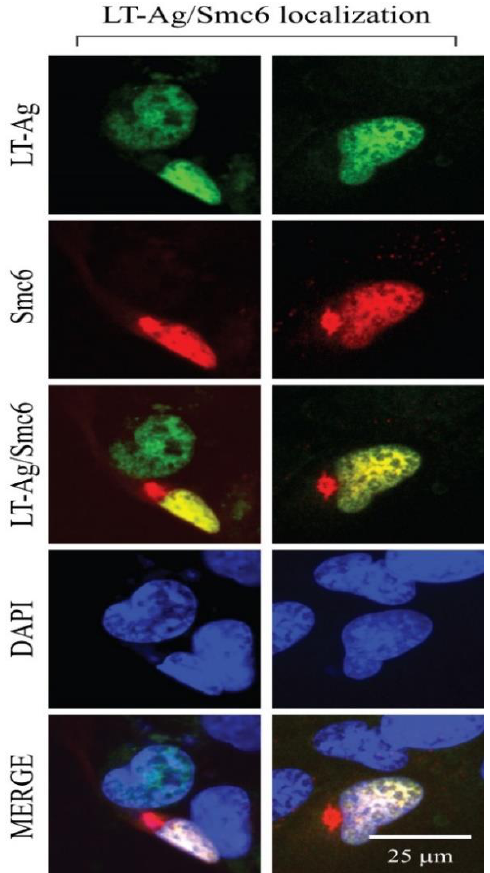
Figure 8. Analysis of the subcellular distribution of JCV LT-Ag and Smc6 by immunocytochemistry (ICC). T7-tagged LT-Ag and FLAG-tagged Smc6 expression plasmids were co-transfected into SVG-A cells and the subcellular localization of both proteins were analyzed by ICC, as described in the Materials and Methods. Briefly, at 16 h post-transfection, cells were transferred to glass-slide chambers and incubated for an additional 24 h. Cells were then fixed in cold acetone and incubated with a combination of α-T7 polyclonal and α-FLAG monoclonal primary antibodies overnight. After extensive washing with 1× PBS, the slide chambers were incubated with the appropriate FITC- or rhodamine-conjugated secondary antibodies, and microscopic images were obtained under a fluorescence microscope, as described in Materials and Methods. Scale bar: 25 µ